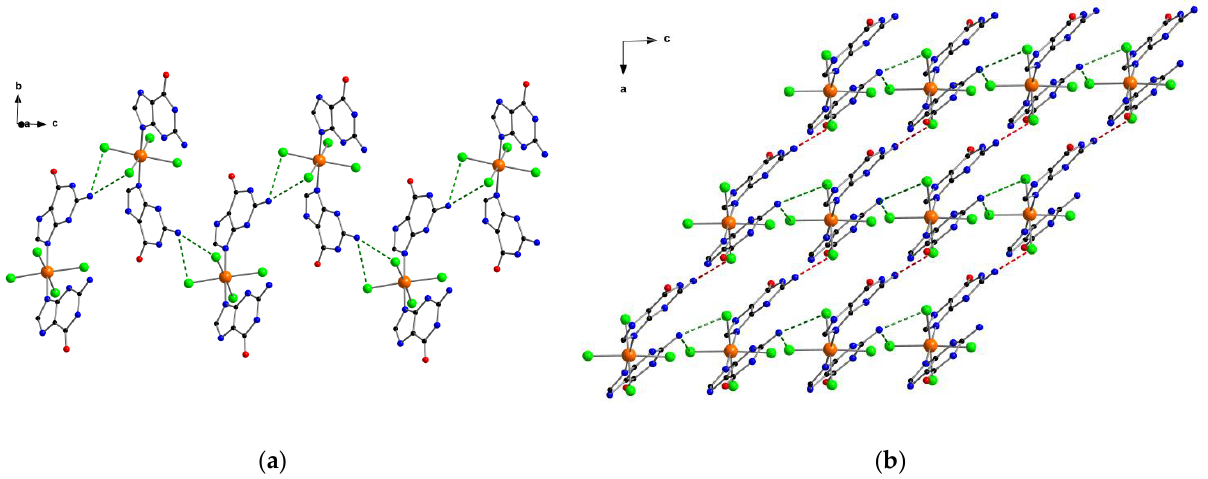
Figure 3. ( a ) Detail of the zig-zag chain formed through bifurcated three-centered hydrogen bonds (dashed green lines) between mononuclear [RuCl 4 (Hgua)(gua)] units in 2 ; ( b ) 2D arrangement of [RuCl 4 (Hgua)(gua)] complexes in 2 connected through additional hydrogen bonds (dashed red lines) and viewed along the crystallographic b axis.